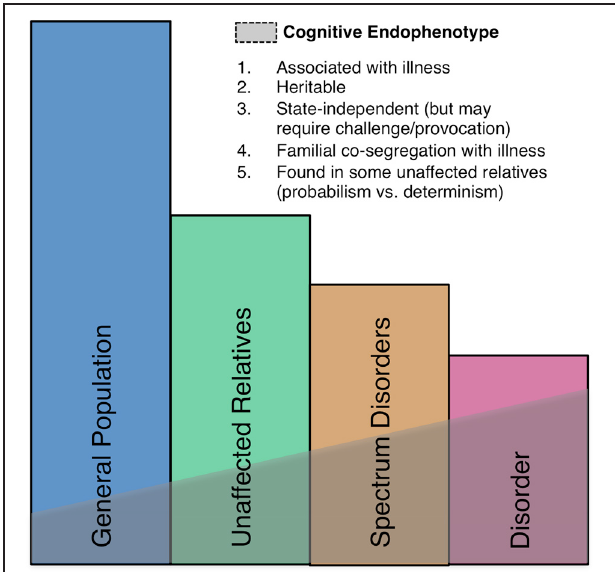
FIGURE 5 | A schematic illustration of the endophenotype concept. Shaded areas indicate the presence of the endophenotype in affected patients, individuals with spectrum disorders, syndromally-unaffected family members and the general population. Criteria taken from Gould and Gottesman (2006).